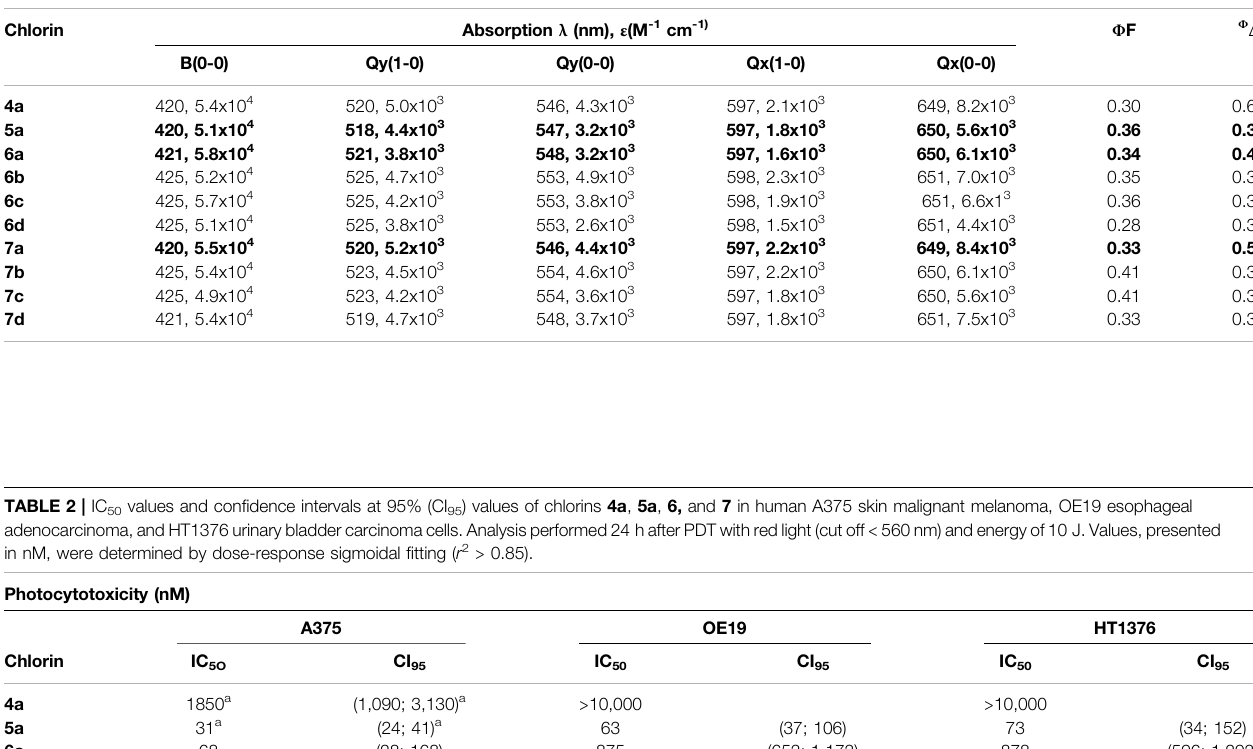
TABLE 1 | Absorption coef fi cients ( ε ), fl uorescence quantum yields ( ϕ F) and singlet oxygen formation quantum yields ( ϕΔ ) of chlorins 4a , 5a , 6 and 7 in DMSO.